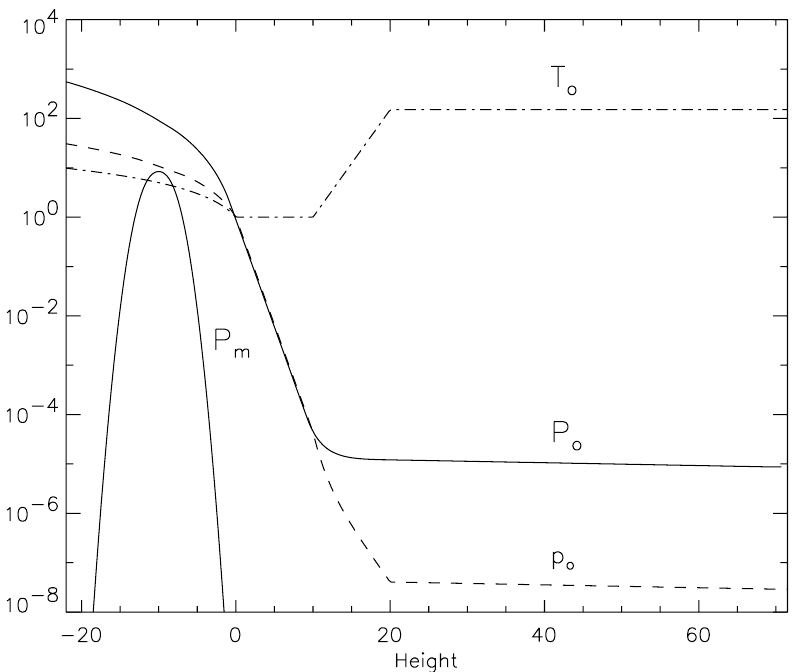
Figure 12: A typical example of a model stratification used for numerical simulations of flux emergence from the convection zone into the corona. In this figure the height scale 𝑧 is expressed in units of 170 km. The solid line (labeled 𝑃 0 ) indicates the height profile of gas pressure in the initial plane-parallel stratifi- cation in units of 𝑝 0 = 1 . 4 × 10 5 dyn cm − 2 . The dashed line indicates the mass density profile in units of 𝜚 0 = 3 × 10 − 7 g cm − 3 . The dash-dotted line indicates the temperature profile in units of 𝑇 0 = 5600 K. The solid line labeled 𝑃 𝑚 indicates the magnetic pressure (in units of 𝑝 0 ) associated with a vertical cut through the mid-plane of the initially horizontal tube. Image reproduced with permission from Archontis et al. (2004), copyright by